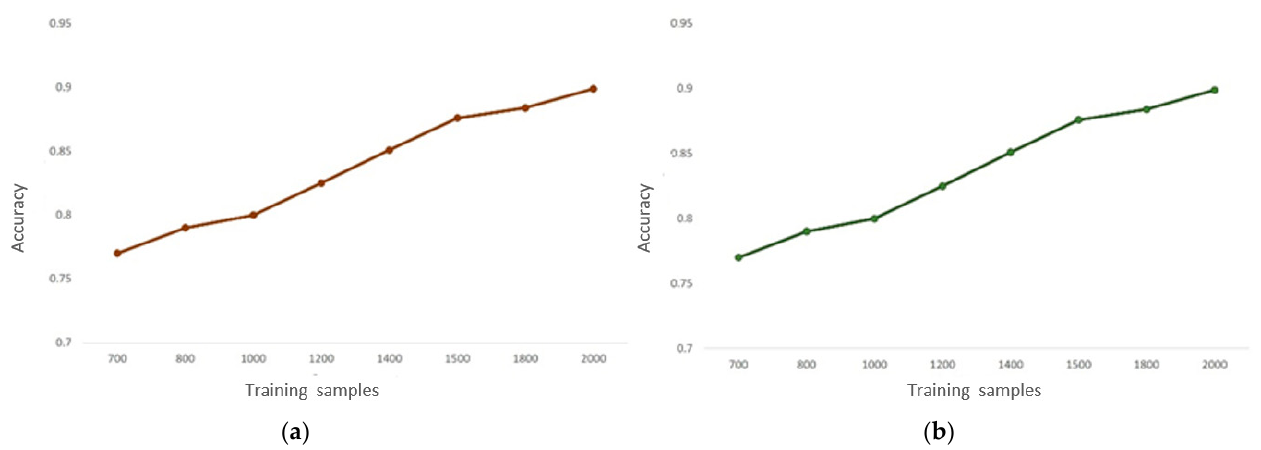
Figure 7. Accuracy and training sample size in FL is a trade-off during this experiment as there will only be a certain number of clients (i.e., six). As the number of training samples per client grows, so does the global model’s accuracy. ( a ) Human visual sentiments dataset; ( b ) Human physical activities